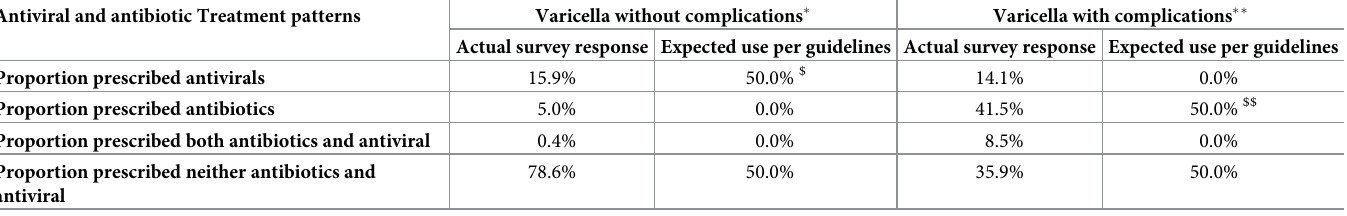
Table 5. Use of antivirals and antibiotics for vignettes with and without complications.